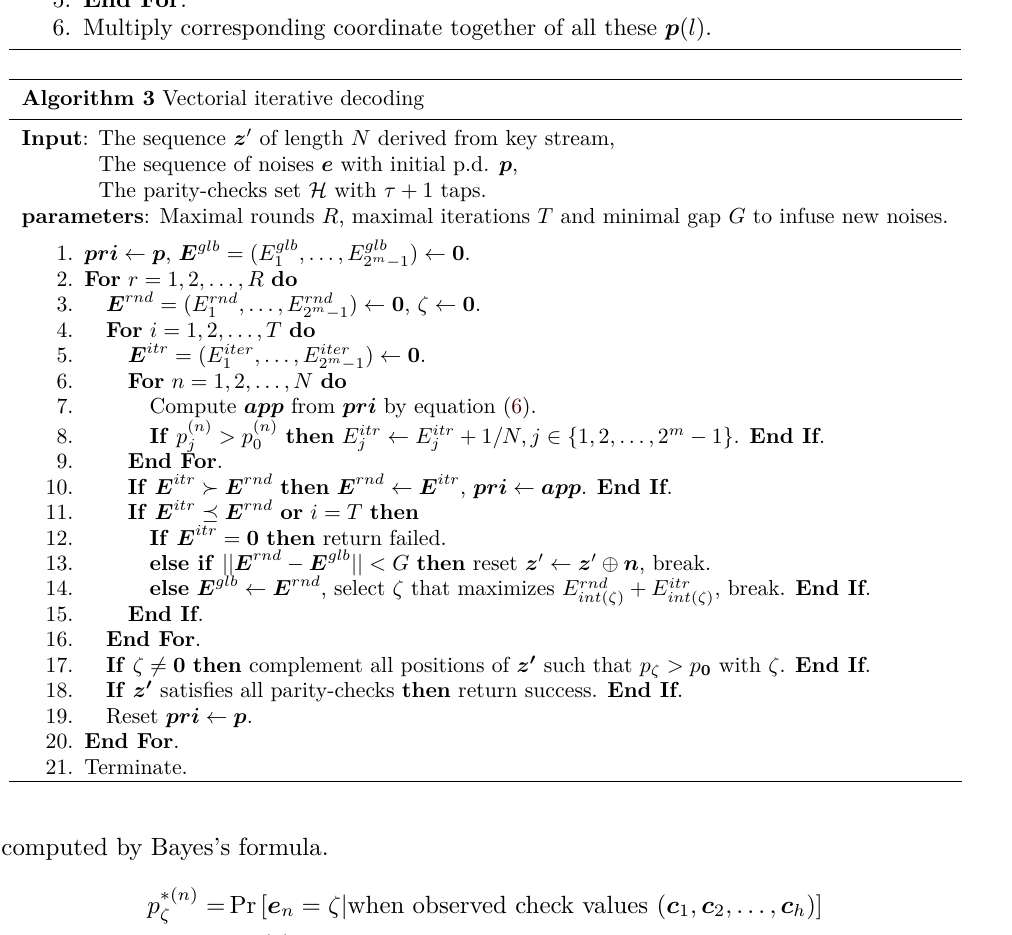
Algorithm 3 Vectorial iterative